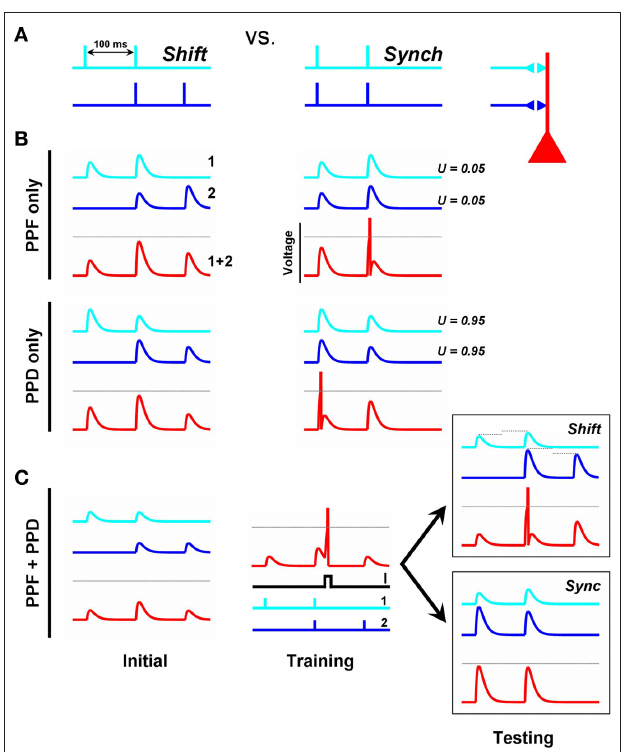
FIgure 1 | Metaplasticity of short-term plasticity. (A) Shift Problem. The goal is for the post-synaptic unit (red) to fire to the shift pattern (left), but not to the synchronous pattern (right). (B) If both input synapses exhibit the same type of STP the shift problem cannot be solved. The traces depict the voltage contribution of each input (light and dark blue) to the total post-synaptic voltage (red). PPF or paired-pulse depression in both inputs cannot solve the problem because the neuron’s peak response (red trace) will always be to the second or first pulse of the Synch pattern, respectively. Each input exhibits PPF or PPD depending on whether the inputs have a low or high U , respectively. (C) A simple learning rule that adjusts the variable U (“Pr”) at each synaptic terminal can solve the shift problem.